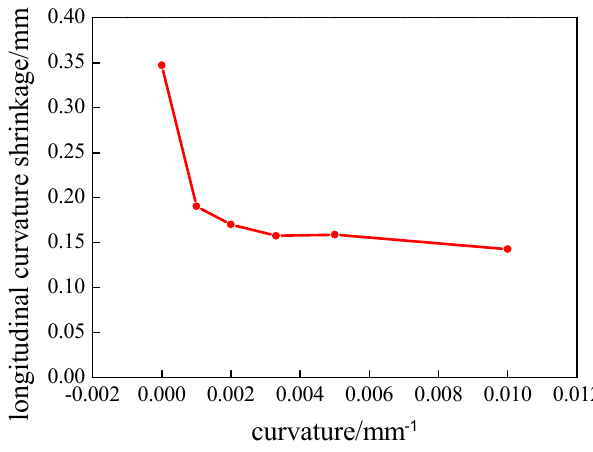
Figure 8. Relationship between curvature and longitudinal shrinkage of welds. The transverse shrinkage in thin bending plate welds is caused by the transverse shrinkage force, which is not only related to the welding process and material properties but also to the cross-section size, material stiffness, and constraint of the test plate. The larger the curvature of the bending plate, the greater the material stiffness and the constraint between the matrix, and the smaller the transverse shrinkage force and the transverse shrinkage. The welding position has little effect on the transverse shrinkage of the bending plate, whereas the effect of curvature is relatively large. The relationship between the transverse shrinkage of the weld and the curvature of the thin bending plate is shown in Figure 9. The fitting of the transverse curvature and the transverse shrinkage of the weld is linear, as can be noted from the following expression: